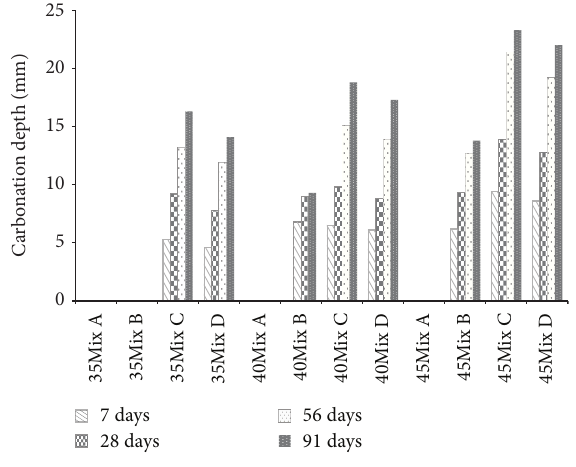
Figure 10: Carbonation